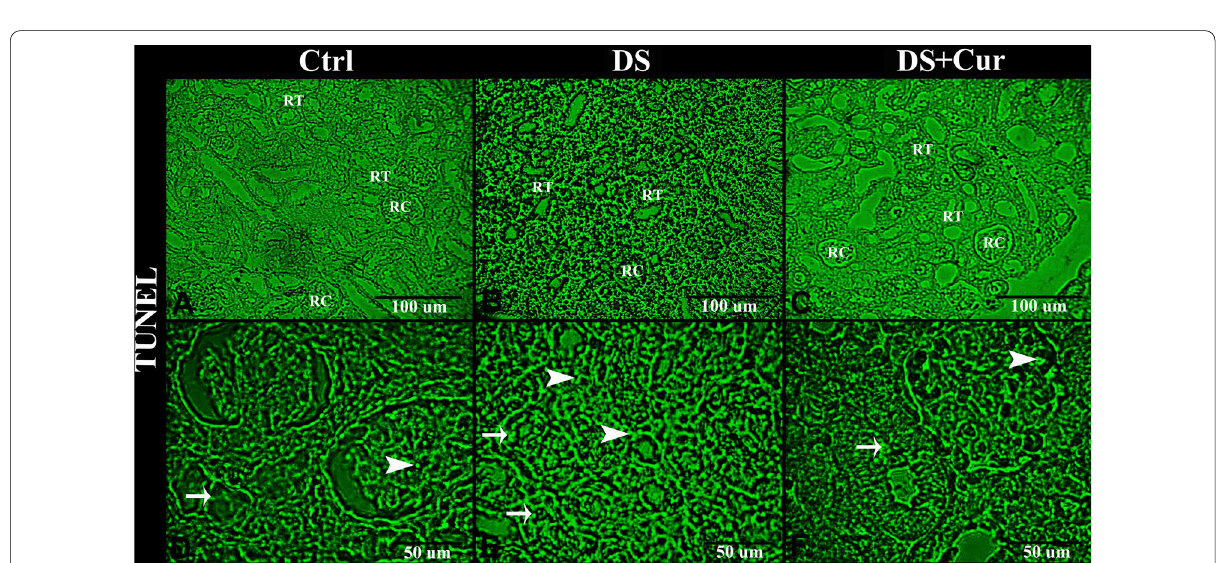
Fig. 8 Fluorescent photomicrograph of TUNEL assay in the paraffin sections of kidney. A (low magnification) & D (high magnification): The kidney of control (Ctrl) group showed few numbers of apoptotic cells in the renal corpuscles (RC, arrowhead) and tubules (RT, arrow). B (low magnification) & E (high magnification): The kidney of diclofenac sodium (DS) group showed high number of apoptotic cells in the renal corpuscles (RC, arrowheads) and tubules (RT, arrow). C (low magnification) & F (high magnification): The kidney of diclofenac sodium showed few numbers of apoptotic cells in the renal corpuscles (RC, arrowheads) and tubules (RT, arrow). Original magnification in A–C, X200, scale bar 100 μm, in D–F X400, scal bar =